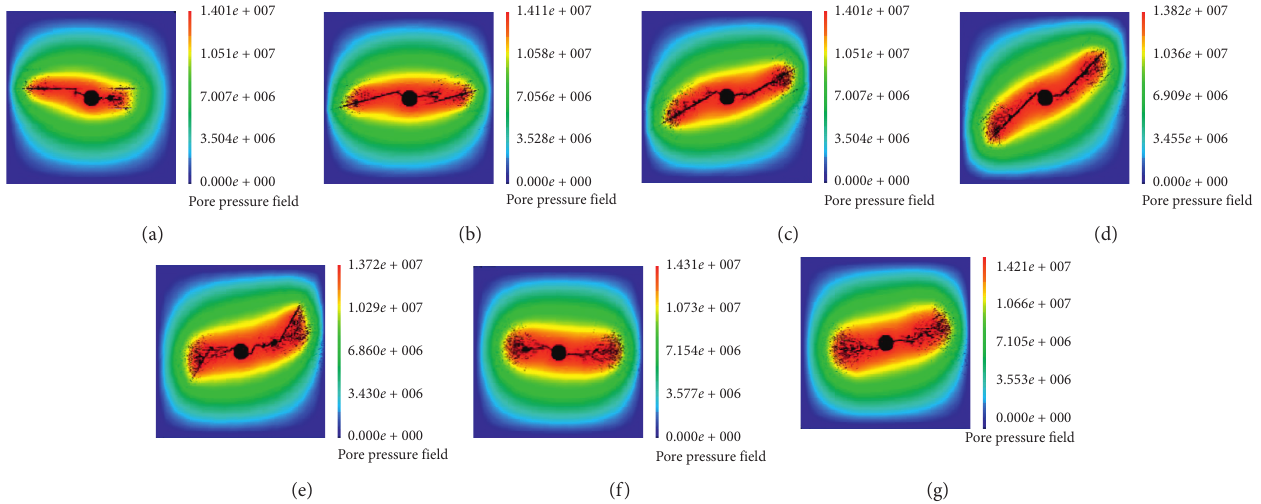
Figure 6: Pore pressure field of models with small confining pressure difference ( σ (d) α � 45 ° , (e) α � 60 ° , (f) α � 75 ° , and (g) α � 90 ° .